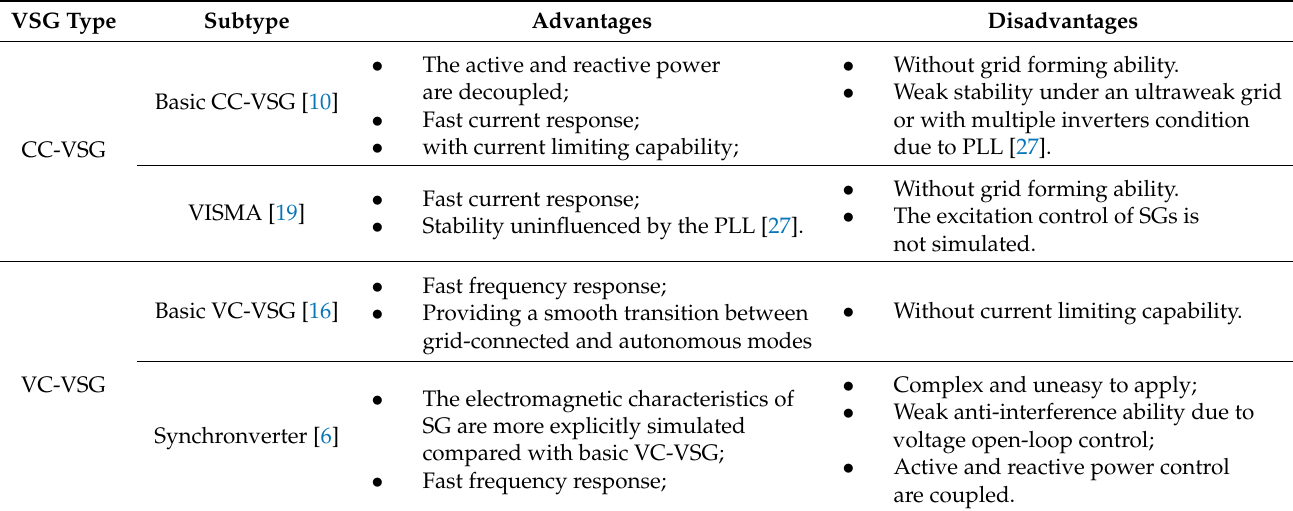
Table 1. Comparison of current-controlled VSG and voltage-controlled